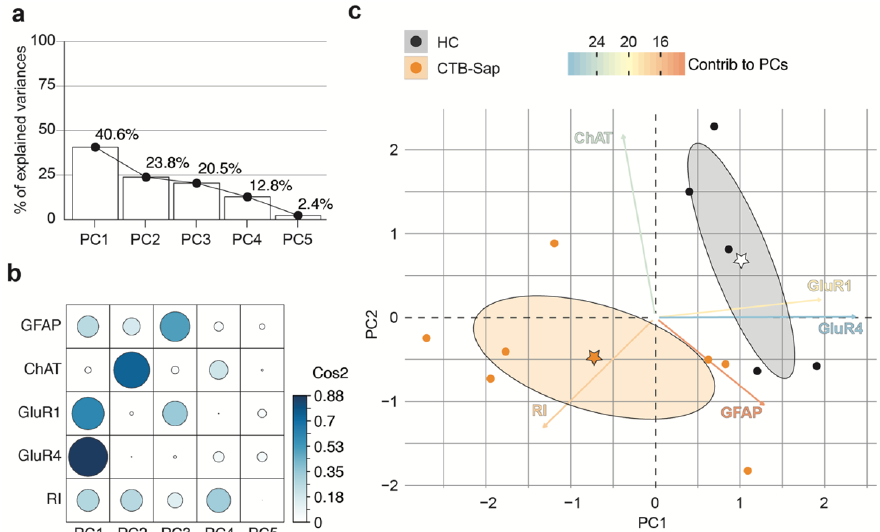
Figure 7. The association between behavioral and molecular outcomes at 42 dpl assessed by principal components analysis (PCA). ( a , b ) Scree plot of PCs (PC1–PC5) and the percentage of GluR1, GluR4, ChAT, and GFAP, and the recovery index (RI) explained variance ( a ) and quality of representation of the variables on the factor map expressed as square cosine (Cos2); ( c ) PCA biplot of GluR1, GluR4, ChAT, GFAP, and RI data for n = 7 CTB-Sap lesioned mice and n = 5 HC mice; key colored arrows represent the variables’ contribution to the PC; stars indicate the mean points of groups, and confidence ellipses are also shown.